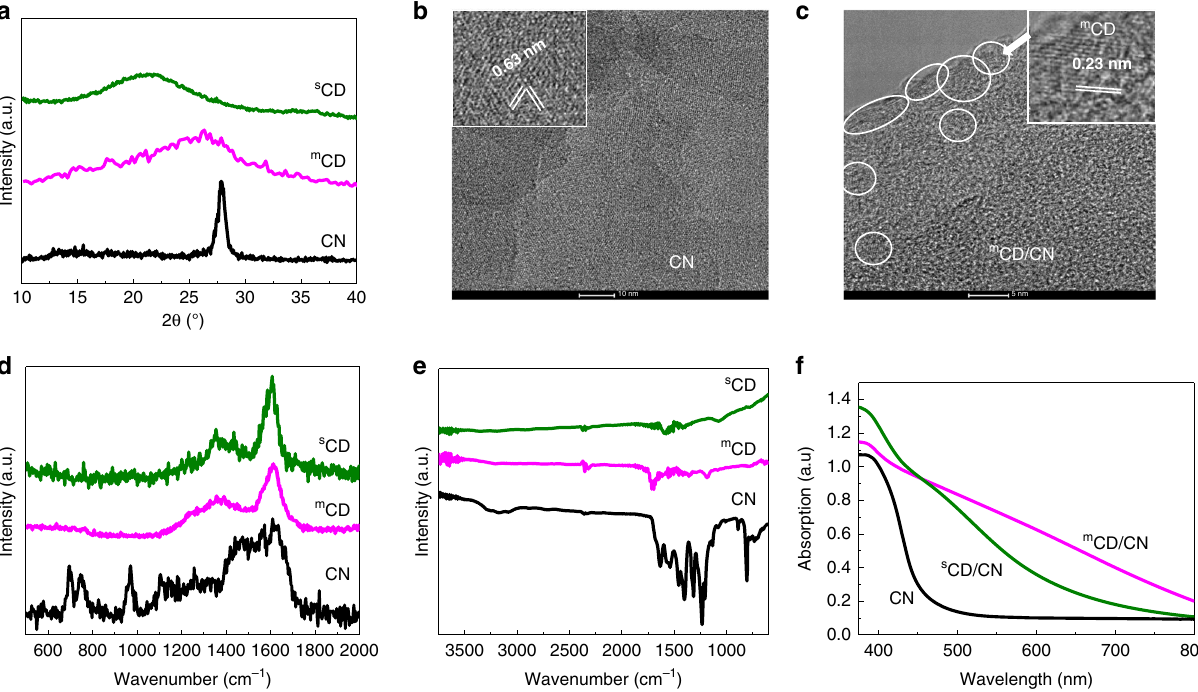
Fig. 1 Characterisation of CN, m CD/CN and s CD/CN. a PXRD pattern of m CD, s CD and CN. b HRTEM images of CN. Scale bar: 10 nm. Inset: an enlarged image showing (110) crystal fringes of CN. c HRTEM images of m CD/CN nanocomposite. Scale bar: 5 nm. m CD are marked by circles. Inset: an enlarged image showing graphite superstructure of m CD. d Raman, e Fourier transform infrared (FTIR) and f UV – vis spectra of m CD, s CD and CN. Source data are provided as a Source Data fi